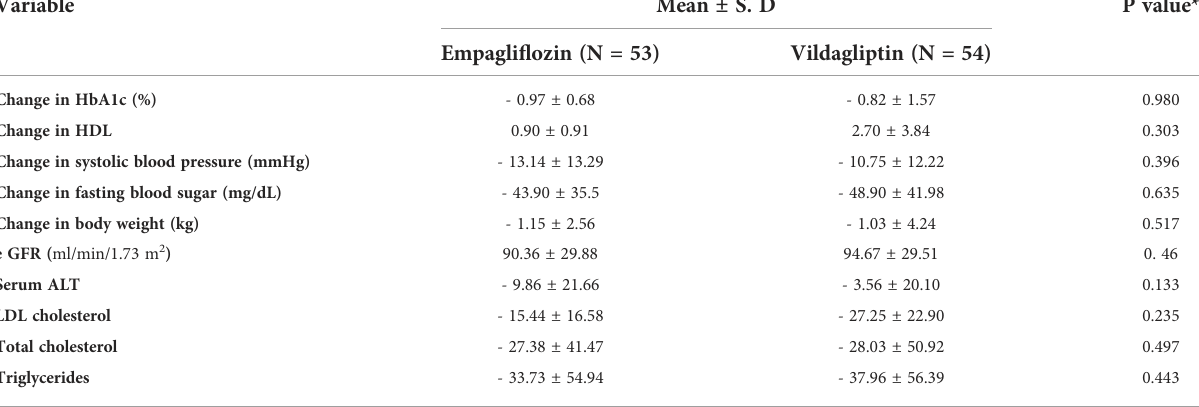
TABLE 2 Change in ef fi cacy and safety variables from baseline to week